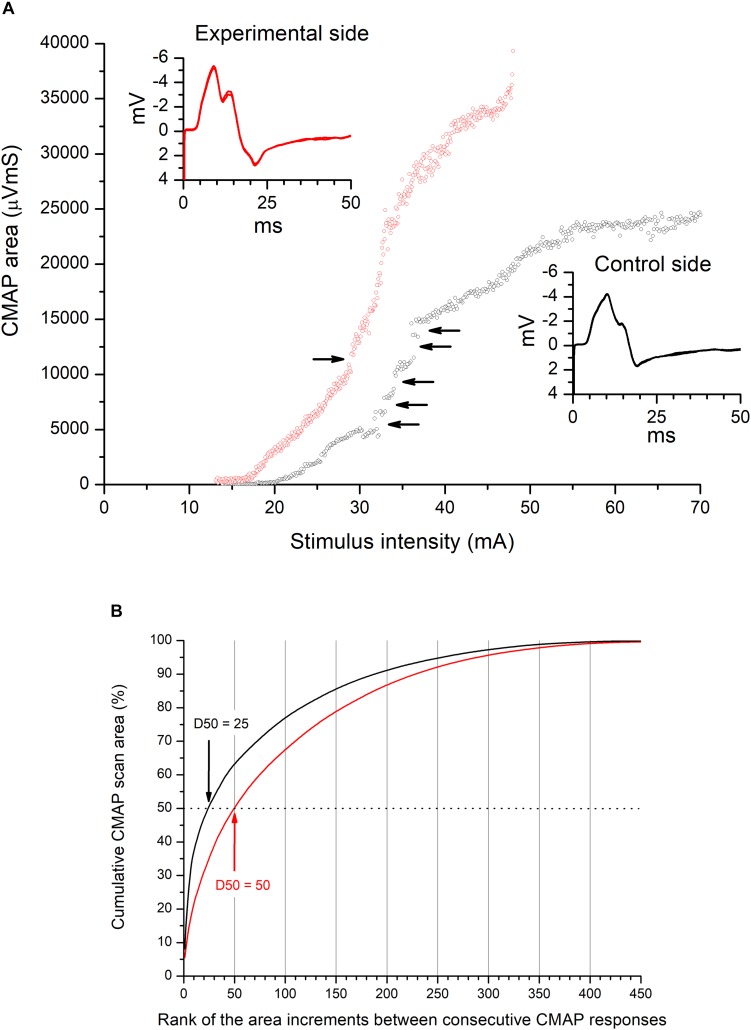
CMAP scan stimulus–amplitude recordings and D50 index. (A) The CMAP scan stimulus–amplitude curve shows the relationship between CMAP size and stimulus intensity, plotted across the range of stimulus intensities from the threshold (S0) to the supramaximal intensity (S100). Each plot shows 500 consecutive values of the CMAP area (mVms) plotted against their stimulus intensities (mA) (0.1 ms duration; delivered at 2 Hz frequency), equally distributed between S0 and S100 in a downward direction. Recordings were made on the control (black symbols) and experimental (red symbols) TA muscles of patient #17 at the + 30-day visit. The comparison of the two curves shows that there are many more CMAP scan discontinuities (marked by horizontal arrows) in the control TA muscle, i.e., more numerous, larger steps during the CMAP scan of the sequential recruiting of the whole muscle fiber population. These discontinuities are caused by a decrease in MU number and an increase in MU size, and may be quantified by the D50 index. The inset shows the shape of the maximum CMAP recorded on both sides. (B) Calculation of the D50 parameter. Each line (control side black, experimental side red) shows the cumulative sum of the increments in the CMAP area between successive responses after ranking these increments from largest to smallest; the D50 parameter is the number of increments necessary to reach 50% of the total sum. For the experimental side (left leg), D50 = 50; for the control side (right leg), D50 = 25. This increase in D50 index on the experimental side with respect to the control side was associated with an increase in axon excitability (measured as the maximum slope of the CMAP scan curve: 0.24 mV/mA on the experimental side and 0.07 mV/mA on the control side).